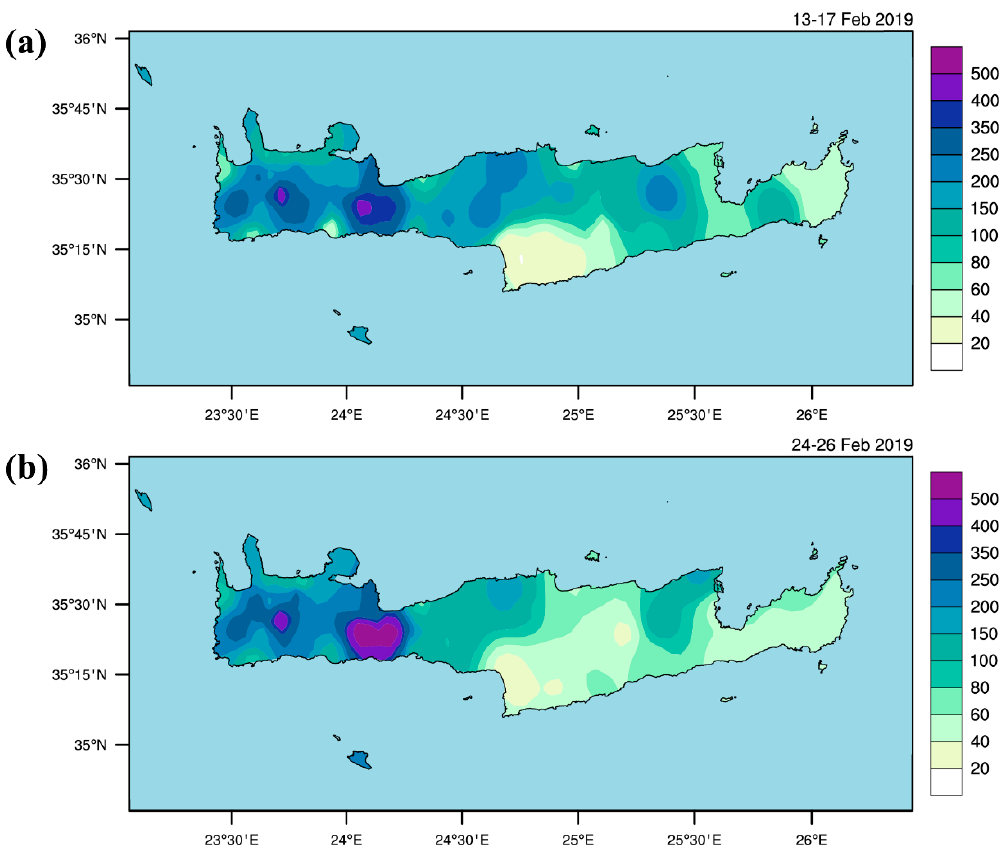
Figure 2. Total accumulated rainfall in Crete ( a ) during Chioni storm for the period spanning from 0000 UTC 13 February to 0000 UTC 18 February 2019 (120 h), and ( b ) during Oceanis storm for the period spanning from 0000 UTC 24 February to 0000 UTC 27 February 2019 (72 h).